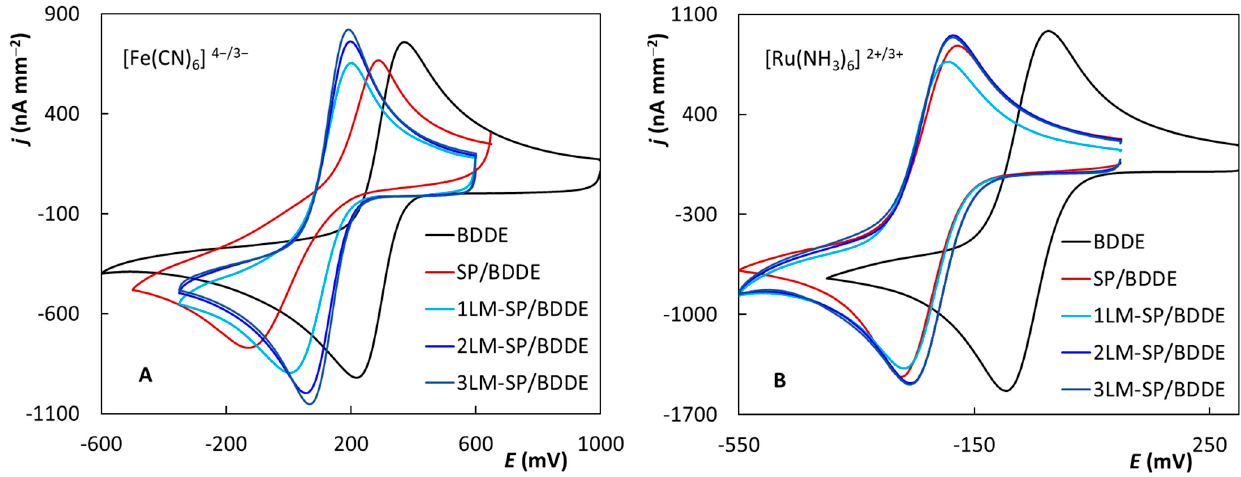
Figure 3. Cyclic voltammograms of [Fe(CN) 6 ] 4 − /3 − ( A ) and [Ru(NH 3 ) 6 ] 2+/3+ ( B ) recorded on the tested sensors (electrolyte—0.1 mol L − 1 KCl, v = 100 mV s − 1 , c ([Fe(CN) 6 ] 4 − /3 − ) = 6.25 × 10 − 4 mol L − 1 , c ([Ru(NH 3 ) 6 ] 2+/3+ ) = 6.25 × 10 − 4 mol L − 1 ). Table 2. Parameters of cyclic voltammograms of redox marker [Fe(CN) 6 ] 4 − /3 − (electrolyte—0.1 mol